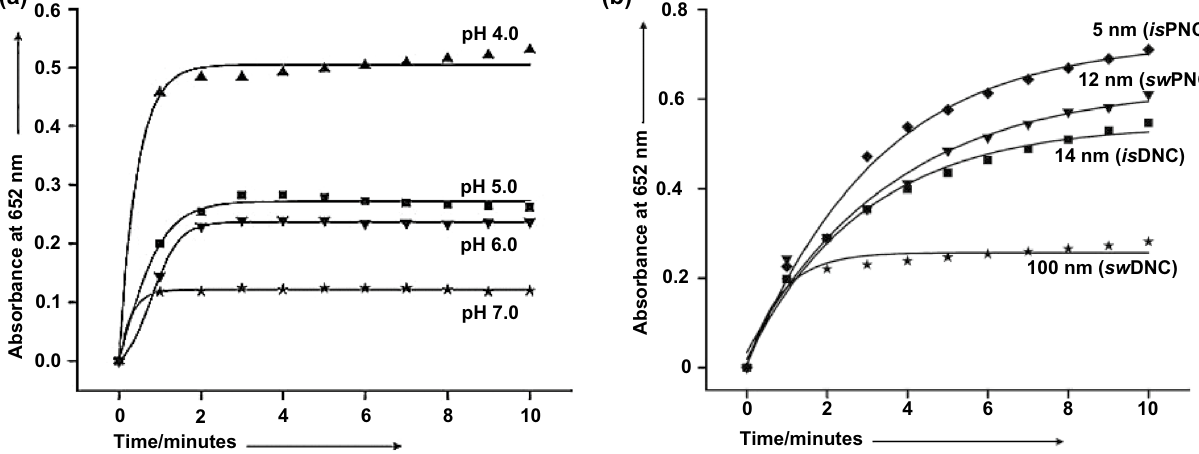
Fig. 4 a–b pH- and size-dependent OXD-like activities of nanoceria indicated by TMB. Reproduced with permission from Ref. [77]. Copyright 2009, WILEY–VCH